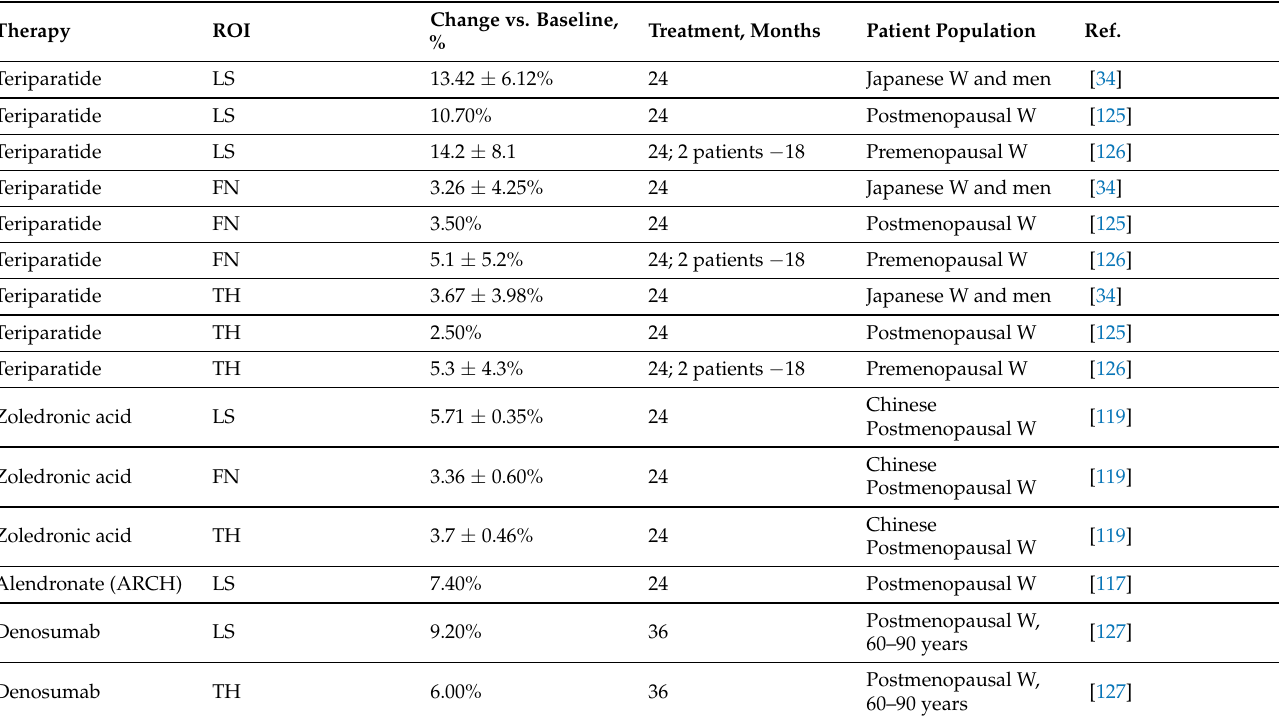
Table 5. Effect of anti-osteoporosis medications treatment for 24–36 months on